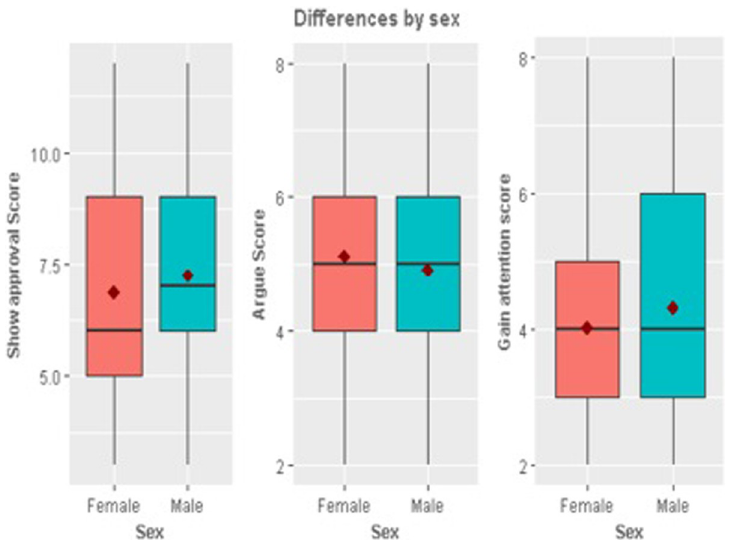
Fig 1. Significant differences by